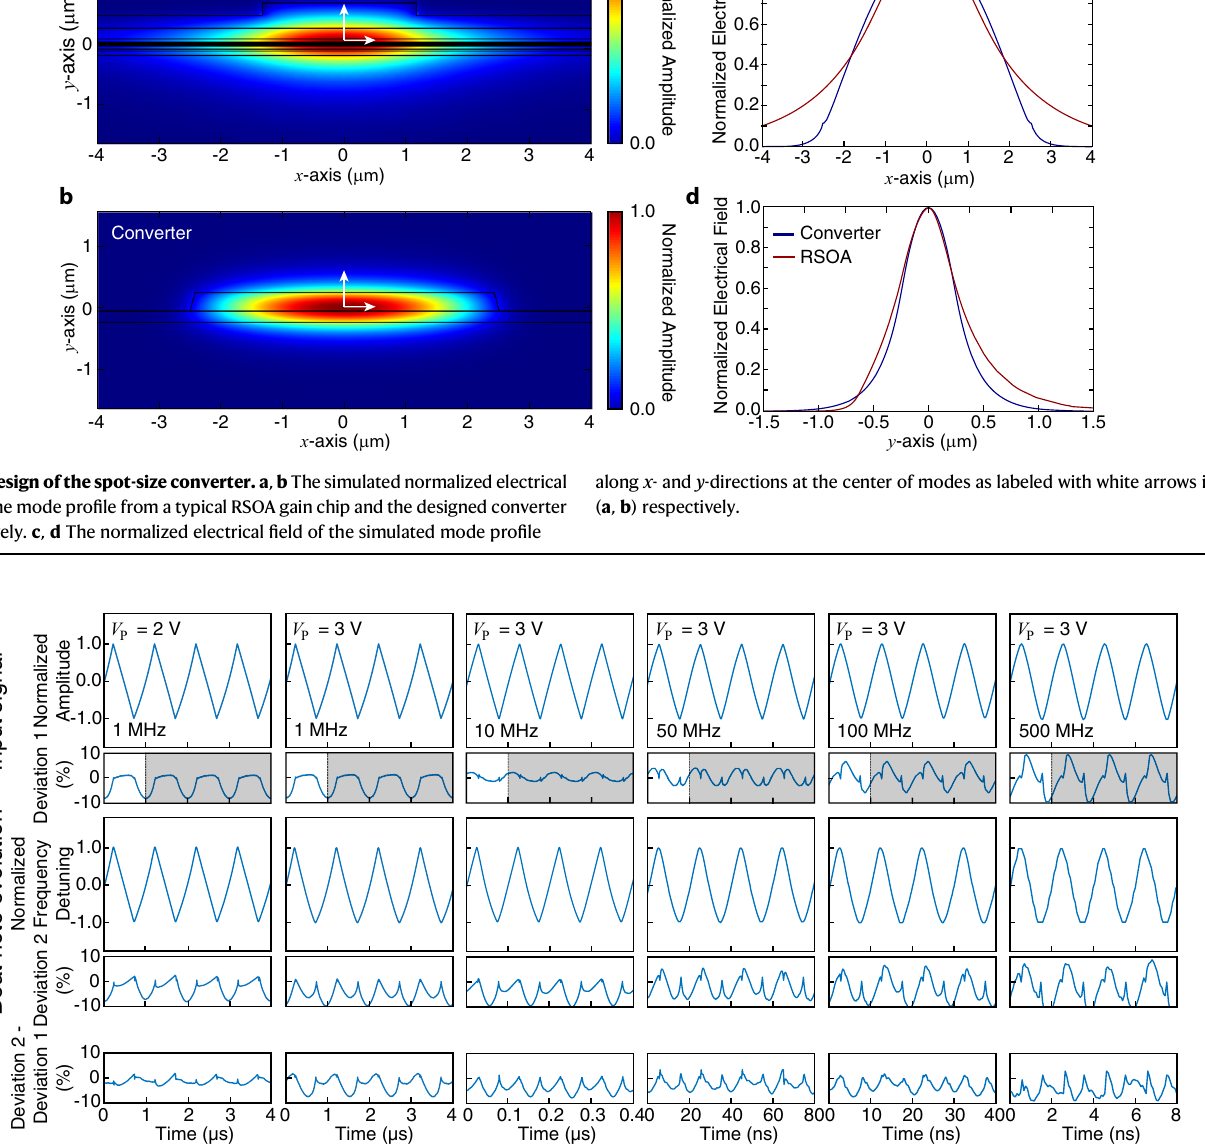
periodic waveform of Deviation 1 is thus obtained by duplicating it over multiple modulationperiodsintime,asshown inthe shaded region.The second row shows the waveform of laser frequency modulation retrieved with STFT from the recor- ded laser beat note. Deviation 2 shows its difference from a perfect triangular function,normalizedbythepeak-peakamplitude.Thelastrowplotsthedifference between Deviation 2 and Deviation